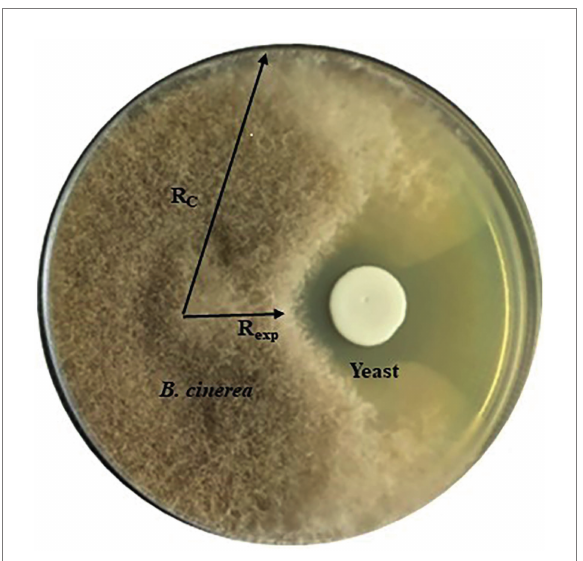
FIGURE 1 A representation of the dual culture assay showing yeast antifungal activity against Botrytis cinerea and how the inhibition was measured. R c represents the longest distance of fungal mycelium growth from the inoculated fungal plug and R exp is the horizontal distance from the inoculated fungal plug towards the yeast